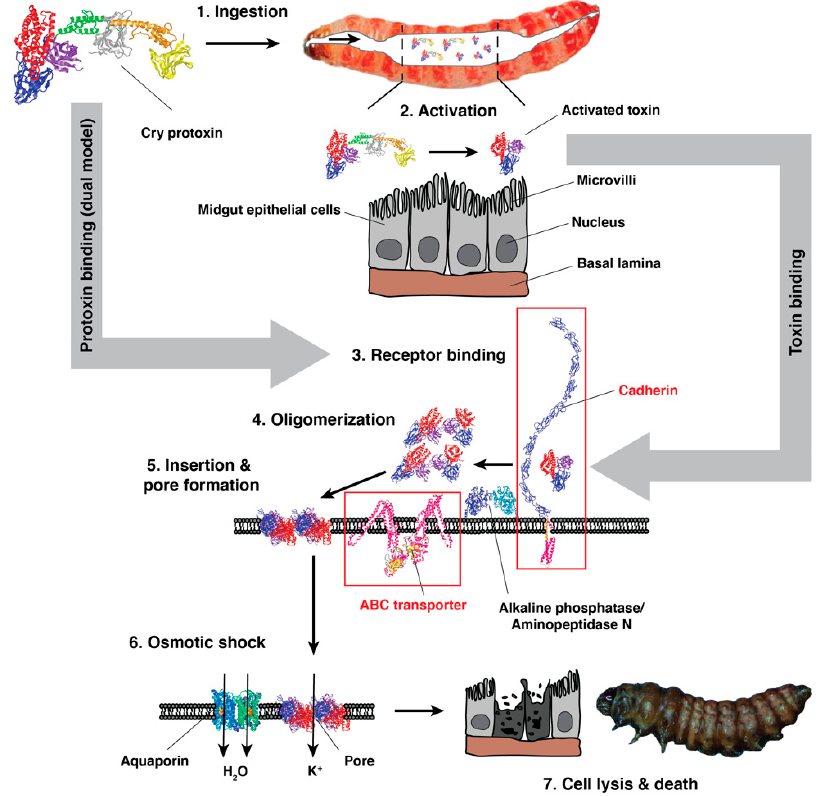
Figure 2. Cry toxin mode of action. Cry toxins must be ingested to kill susceptible larvae (Step 1). In the standard pore formation model, Cry protoxin must be activated by insect proteases (Step 2), and the smaller activated toxin binds to primary receptor proteins (e.g., cadherin and ABC transporters) at the surface of the midgut epithelium (Step 3). Next, Cry toxin oligomerizes (Step 4) and interacts with co-receptors (alkaline phosphatase and/or aminopeptidase N). The oligomers insert into the epithelial membrane forming pores (Step 5). The rapid influx of cations through these pores causes osmotic shock in the midgut cells (Step 6). The cells swell due to the uptake of water through aquaporin water channel proteins and eventually lyse. Ultimately, the insect dies from acute damage, starvation, and/or septicemia (Step 7). A new “dual” model proposes that protoxin, as well as activated toxin, binds to midgut receptors and causes toxicity via a second pathway.